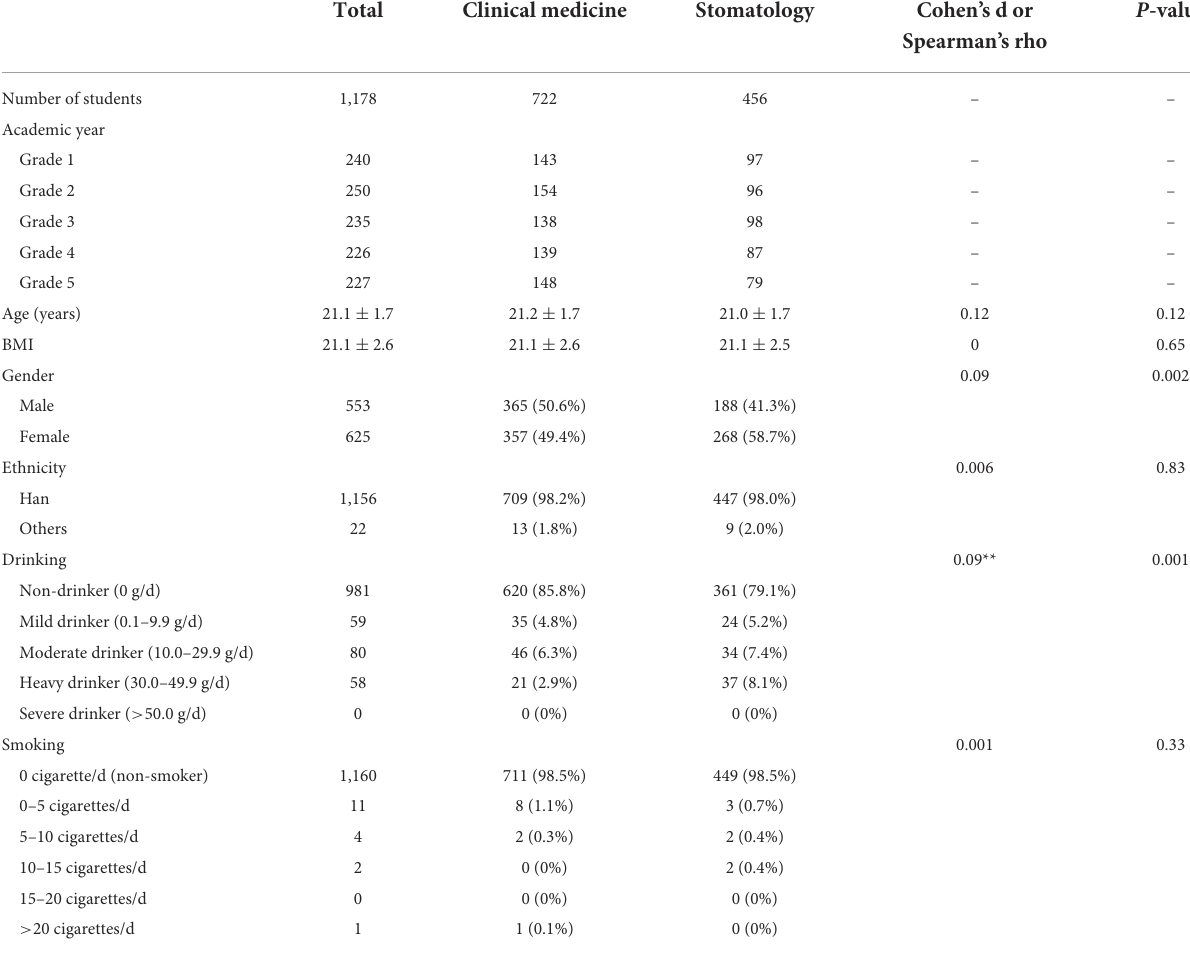
TABLE 1 Demographic characteristics of included participants ( N =